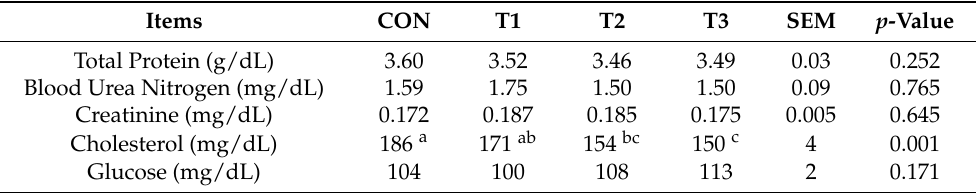
Table 9. Effects of full-fat almonds on blood profiles in broiler chickens.